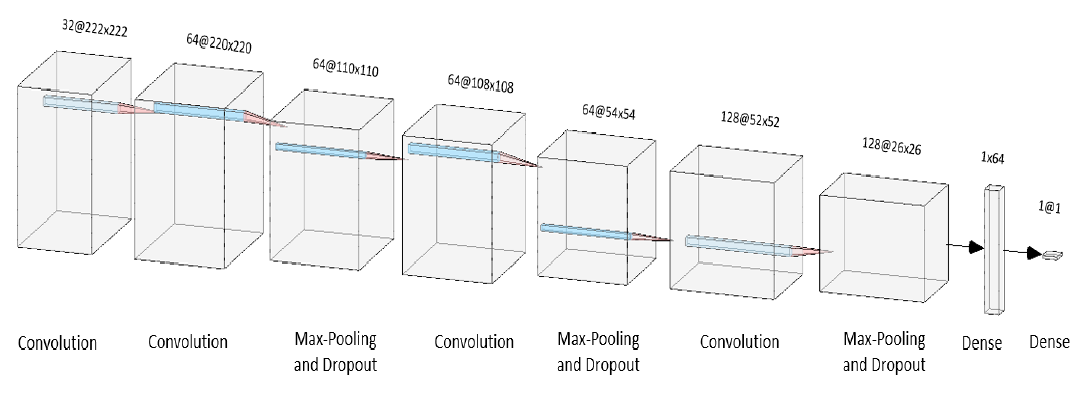
Figure 5. Complete layered architecture of proposed CNN model.